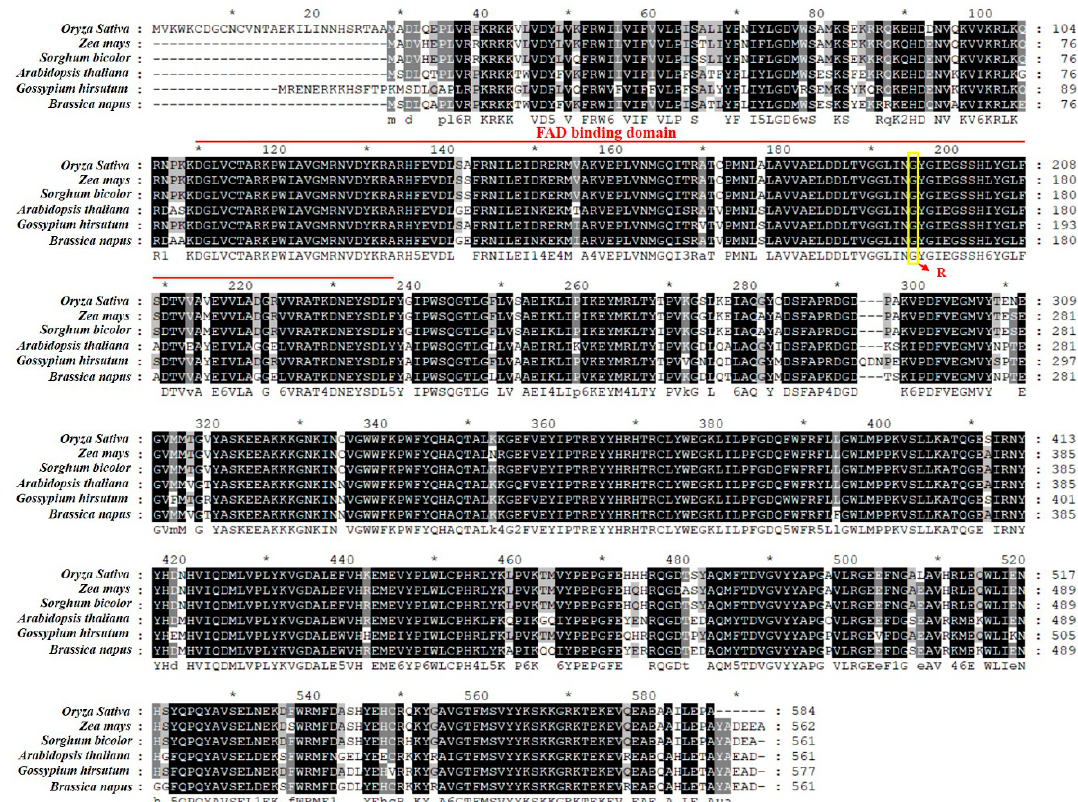
Figure 4. ClustalW alignment of the orthologs of LTBSG1. The orthologs of LTBSG1 from different plants were Zea mays (Accession Number NP_001105560.1), Sorghum bicolor (XP_021306085.1), Arabidopsis thaliana (NP_188616.1), Gossypium hirsutum (XP_016697581.1) and Brassica napus (XP_013721305.1), respectively. The red line region represented the FAD-binding domain (110-237 amino acids) and the amino acid substitution (G-R) was indicated by the yellow frame.